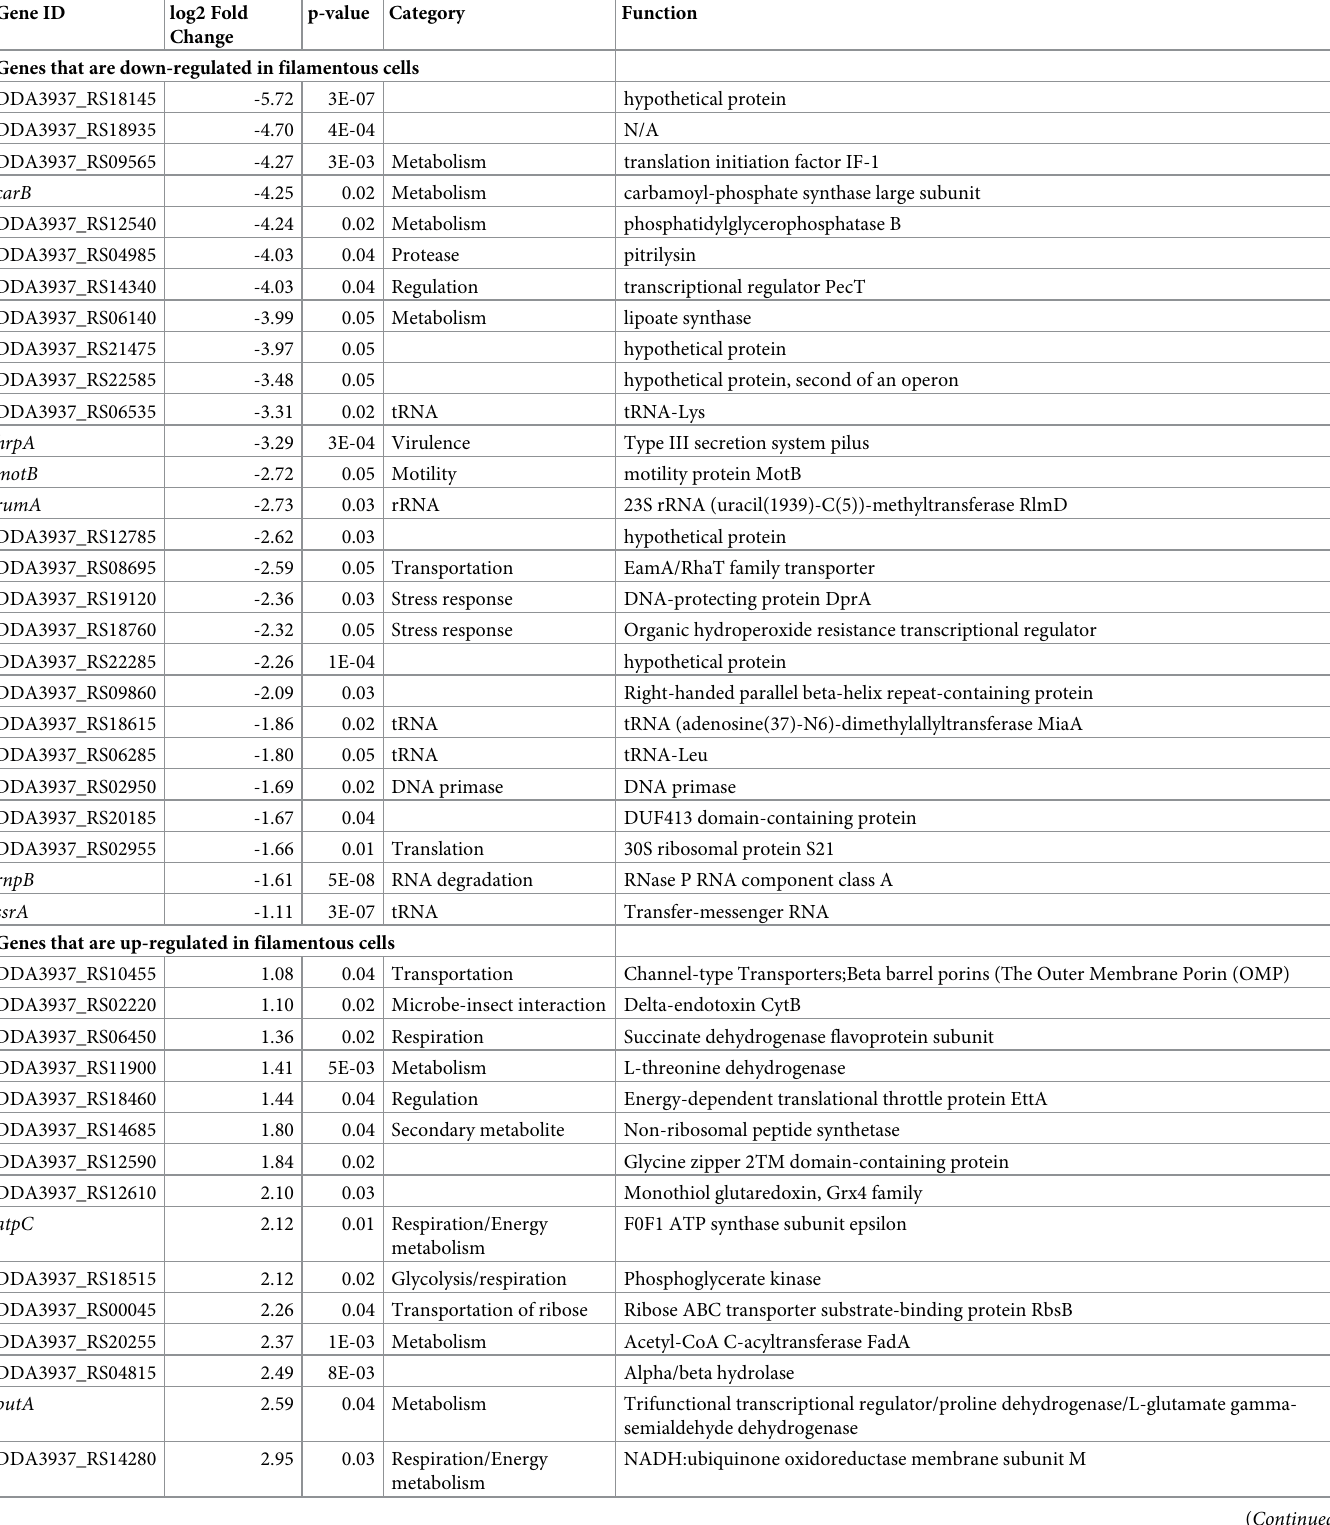
Table 2. Genes with altered expression in filamentous cells compared to short cells identified in RNA-seq. Gene ID log2 Fold p-value Category Function Change Genes that are down-regulated in filamentous